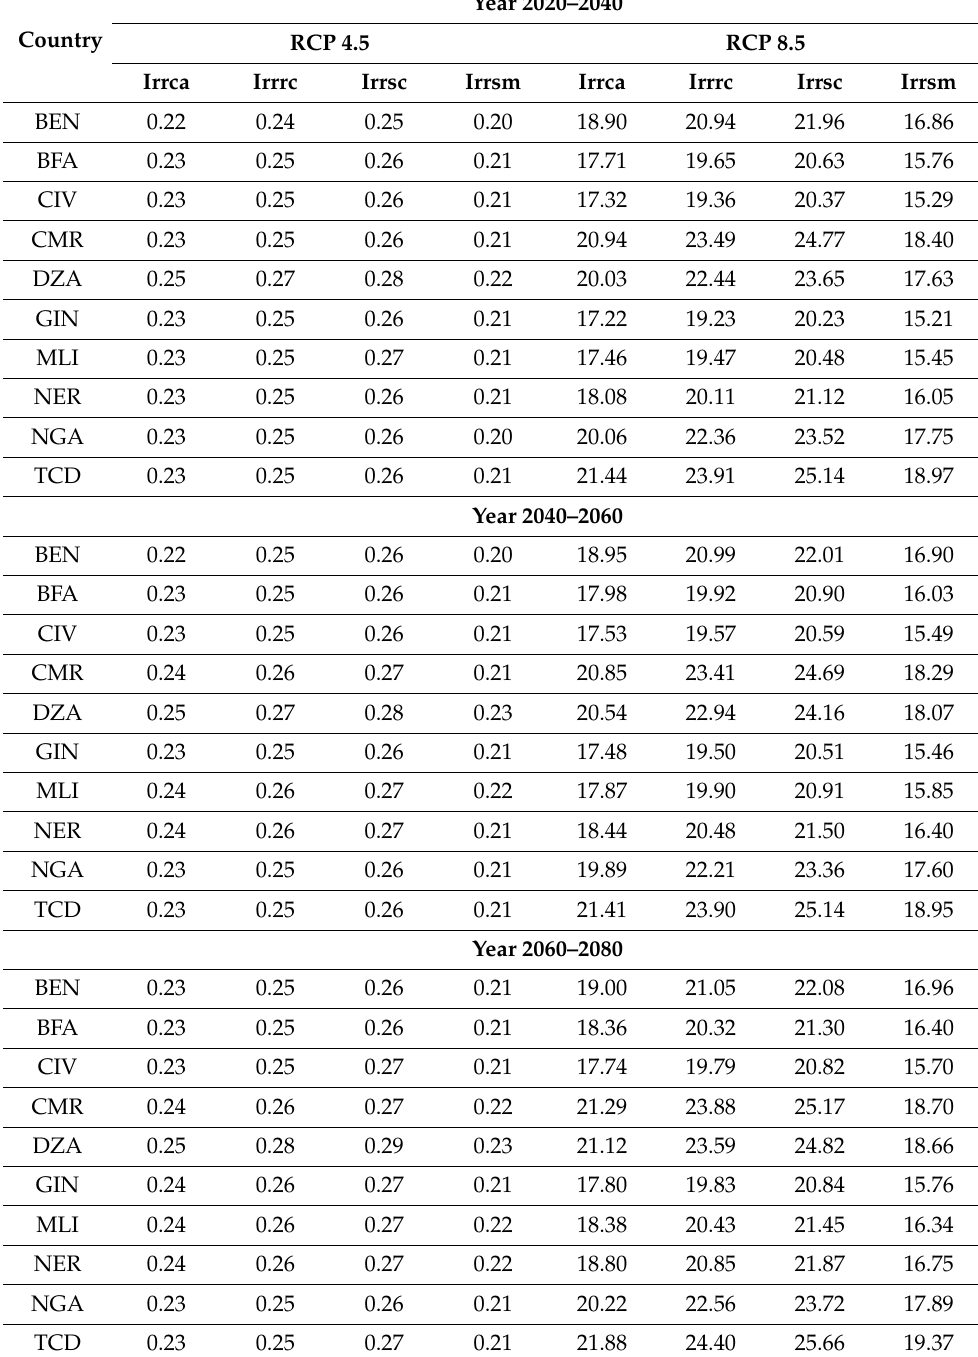
Table 3. Total irrigation water requirements (IRW) in mm/day under MIROC